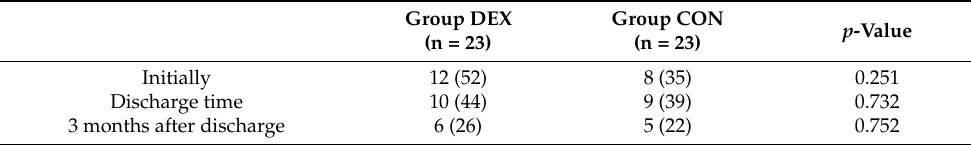
Table 3. Dementia rate at different time points during the